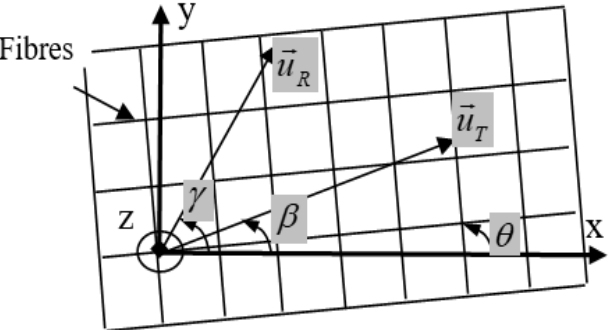
Figure 17. Coordinate system used in bidirectional reinforced composite material.